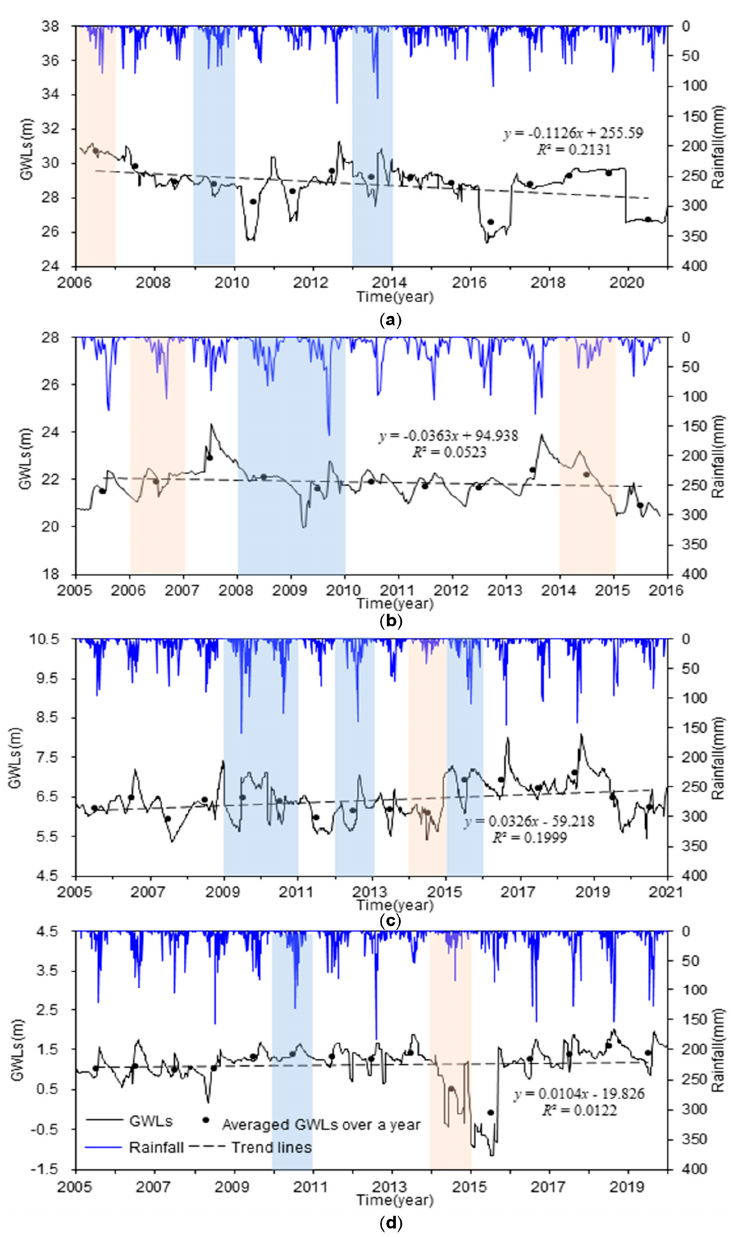
Figure 3. Observed time series of rainfall and GWLs at ( a ) W1, ( b ) W2, ( c ) W3, and ( d ) W4. The blue and orange bands indicate the wet year and dry year, respectively.